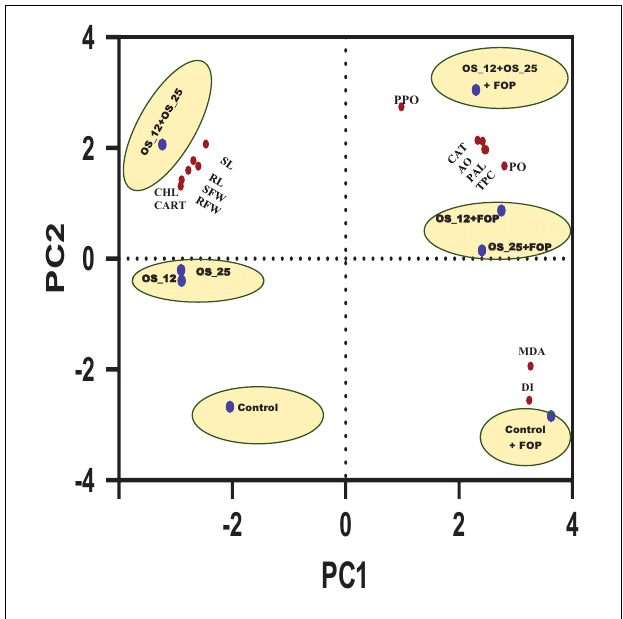
FIGURE 13 | Principal component analysis of effect of different treatment (shown in circles with blue dot) with respect to control (uninoculated) and bacterial inoculation either single (OS_12 or OS_25) or in combination (OS_12 + OS_25) in the presence and absence of F. oxysporum f. sp. pisi (FOP) on growth parameters, defense enzymes and mortality rate of pea plants (shown in red dots). The X -axis and Y -axis of PCA plot represent first and second principal components (PCs). Symbols: RL, root length; SL, shoot length; SFW, shoot fresh weight; RFW, root Fresh weight; CHL, chlorophyll content; CART, carotenoid